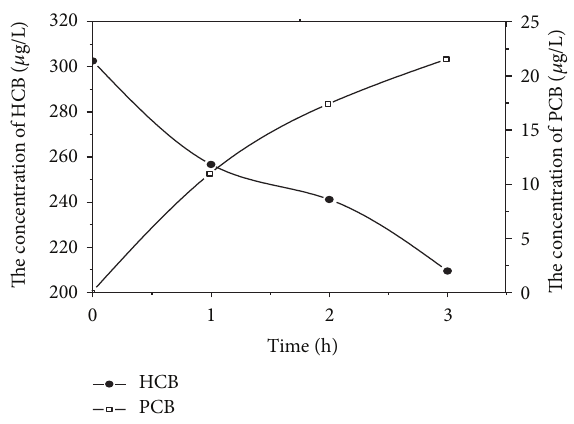
Figure 4: Variation of HCB and its dechlorination intermediates concentration using graphite cathode.